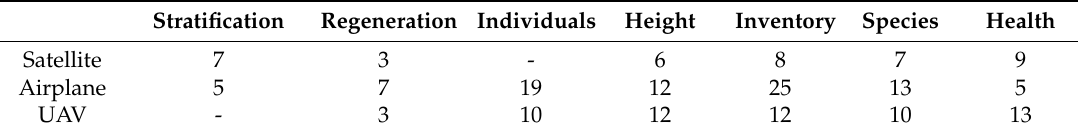
Table 1. Numbers of works summarized in this review according to sensor carrier and application. UAV: unmanned aerial